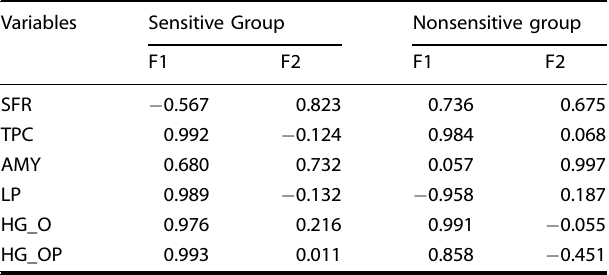
Table 2. Factor loadings of the analytical variables. Variables Sensitive Group